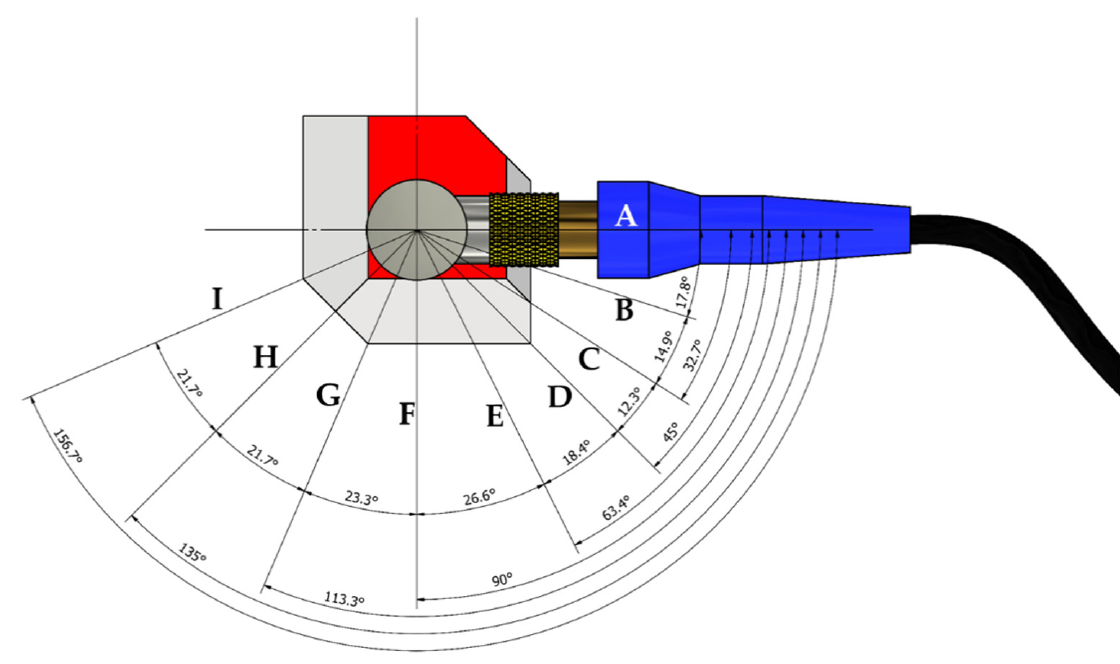
Figure 7. Schematic setup for measuring the shear SWV at different angles. A–I represent different angles of the acoustic probe at which the waveforms were captured.